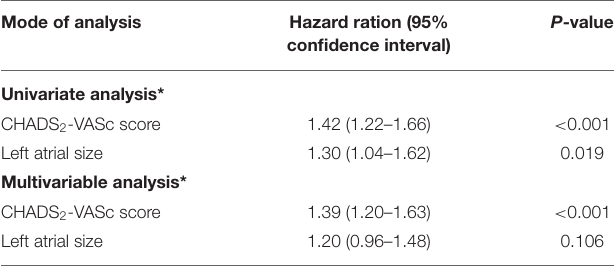
TABLE 2 | Univariate and multivariable analyses in Cox